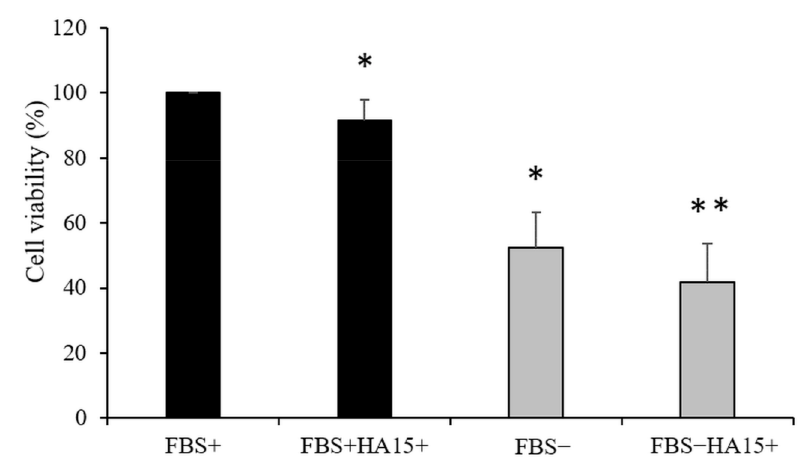
Figure 2. Viability of normal human melanocytes in response to 10 µ M of HA15 treatment. First, cells were starved for 14 h and then cultured under normal culture conditions (black columns: FBS+) or cultured without FBS (grey columns: FBS − ) or treated with 10 µ M of HA15 (FBS+ HA15+ and FBS − HA15+) for 48 h. Data are presented as the mean ± SD of three independent experiments. Asterisks represent significant differences (* p ≤ 0.05; ** p ≤ 0.01).